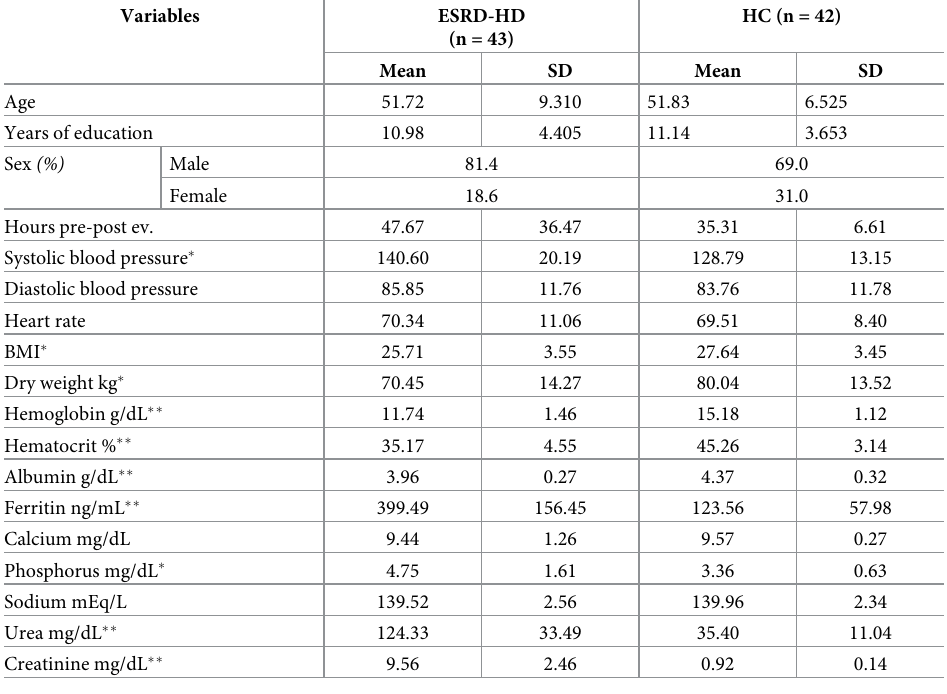
Table 1. Sociodemographic, biochemical, blood pressure and body composition data as a function of group.